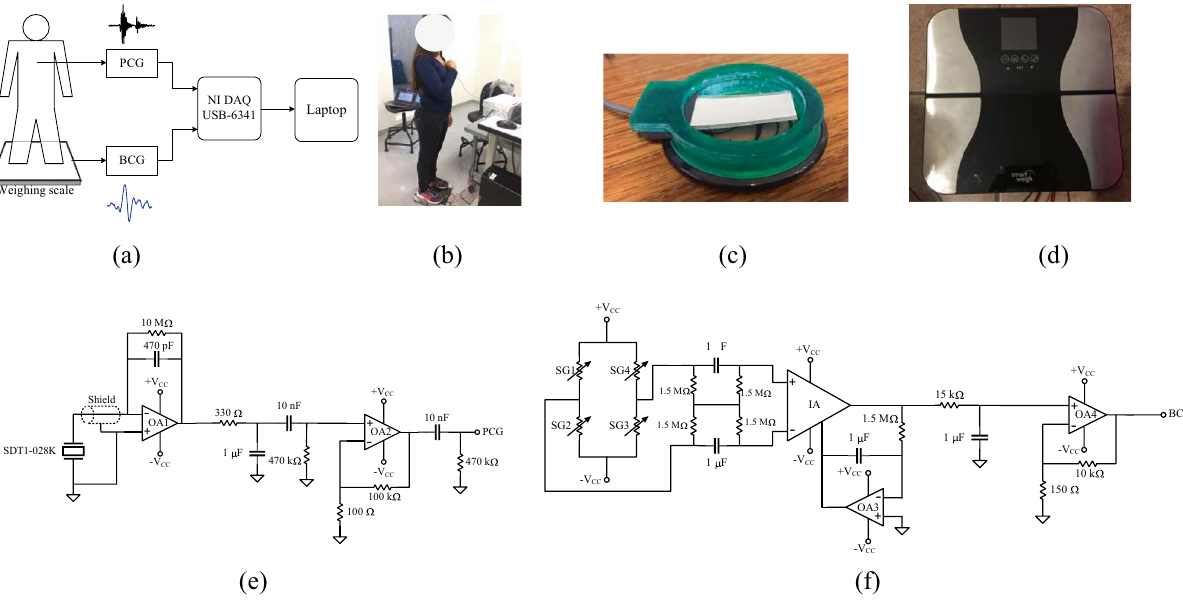
Figure 2. ( a ) Setup for detecting the PCG and the BCG simultaneously. ( b ) One of the volunteers using the measurement setup. ( c ) SDT1-028 K mounted on a custom-built case used for detecting the PCG. ( d ) Electronic weighing scale used for detecting the BCG. ( e ) Circuit used to detect the PCG, and ( f ) circuit used to detect the BCG. Figures ( a , e , f ) were drawn in Microsoft Visio Professional 2019 24 by Rafael